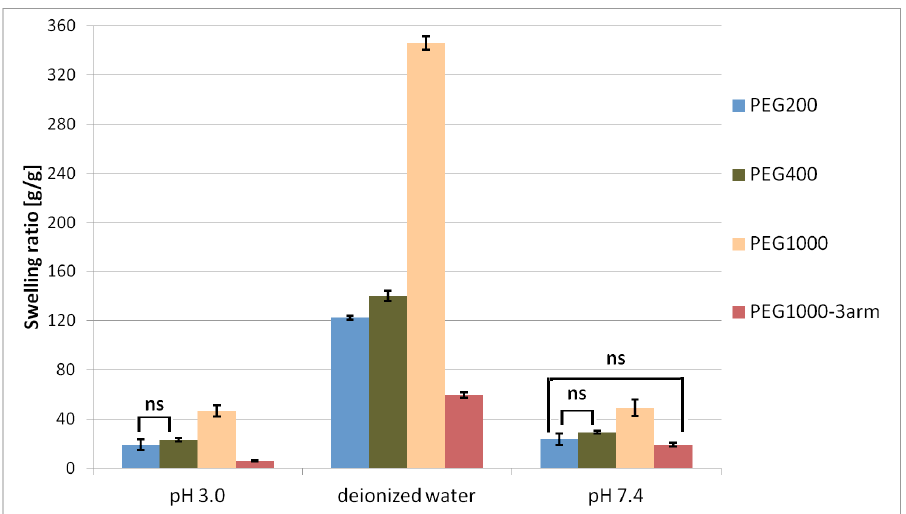
Figure 3. Studies on swelling behaviour of γ -PGA-based hydrogels carried in phthalate buffer at pH = 3.0, deionised water, and phosphate-buffered saline at pH = 7.4 ( n = 3; error bars, standard deviation; ns = nonsignificant with p > 0.05).